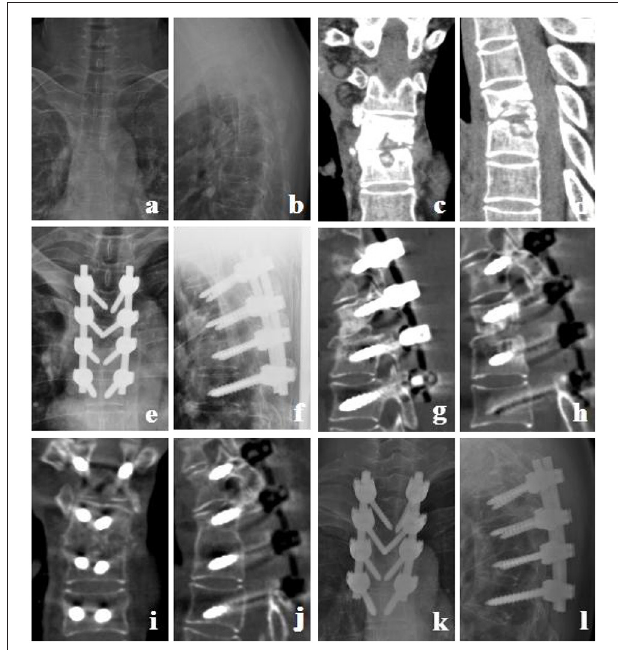
FIGURE 2 | Transverse process bone graft group. A 43-year-old female with T4-5TB received a transverse processes bone graft for reconstruction. (a–d) Preoperative X-ray and CT showed that T4 and T5 vertebral margins were irregularly destroyed and the intervertebral space narrowed. (e,f) Postoperative X-ray. (g–j) CT at 7 months postoperative showed bone fusion between T4 and T5. (k,l) X-ray at 12 months postoperative showed good location of posterior instrument and normal thoracic